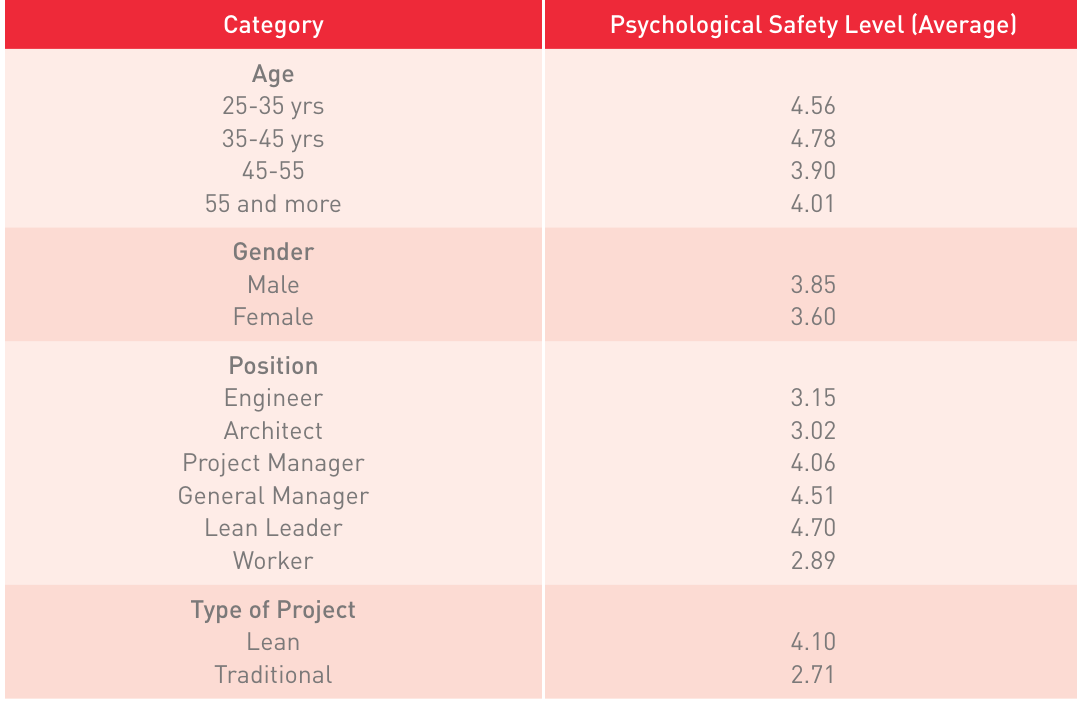
Comparison of psychological safety levels concerning age, gender, position, and Lean